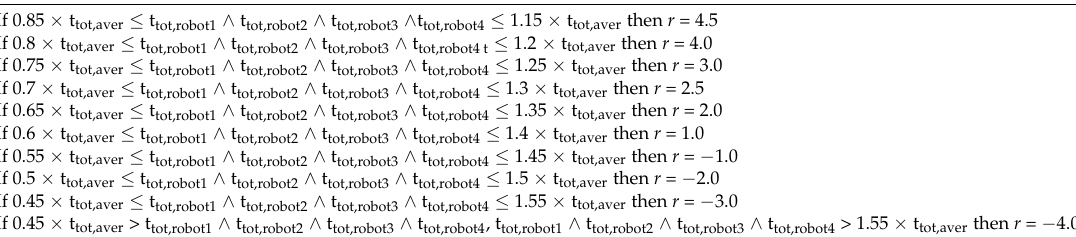
Table 7. Immediate reward (r) values.